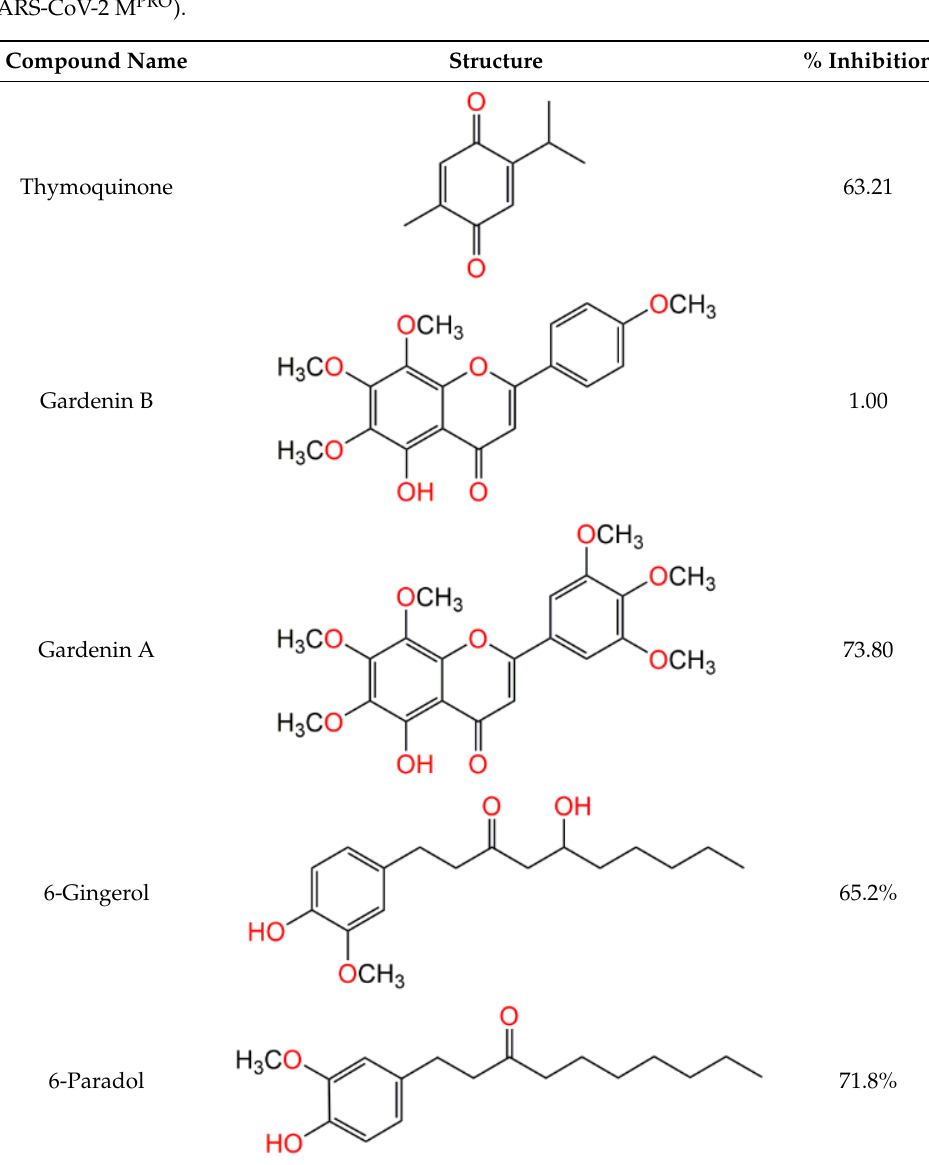
Table 2. Percentage inhibition of the isolated compounds from bioactive extracts against viral protease (SARS-CoV-2 M PRO ).